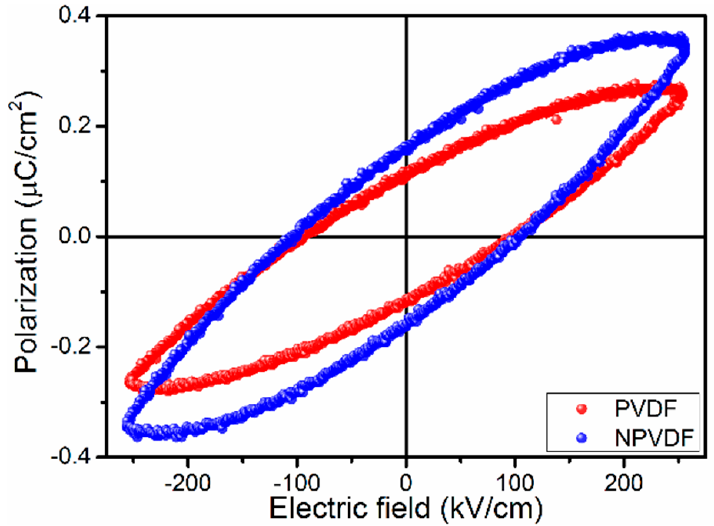
Figure 8. P-E hysteresis loops of PVDF and NPVDF fi lms.